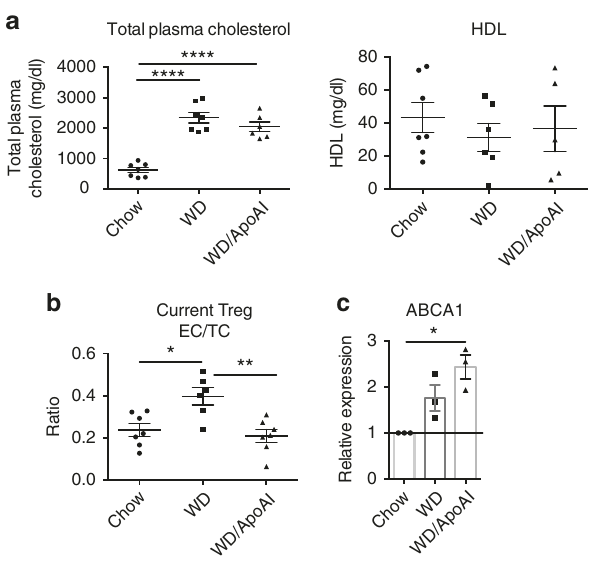
Fig. 9 ApoAI administration reduces the cholesterol content in current Treg cells through increasing ABCA1 expression. a Plasma from LT-ApoE − / − western diet-fed mice with and without ApoAI treatment or chow controls were tested for total cholesterol and HDL. b Sorted current Treg (RFP + YFP + ) cells from PaLN of the above mice were analyzed for the amounts of intracellular free and total cholesterol using mass spectroscopy. The amount of esteri fi ed cholesterol was calculated followed by the ratio of esteri fi ed to total cholesterol. c The mRNA expression of ABCA1 by RT- qPCR from RNA extracted from current Treg sorted from the PaLN of chow and western diet-fed LT-ApoE − / − mice, with and without ApoAI treatment. The data were analyzed using the 2 − ΔΔ Ct method and it was normalized to β -actin . Results are expressed as the mean ± s.e.m from one experiment ( n = 7) ( a , b ), and mean ± s.e.m from one of two independent experiments ( n = 3) ( c ). Statistical signi fi cant differences were at * P < 0.05, ** P < 0.01 and **** P < 0.0001 (one-way